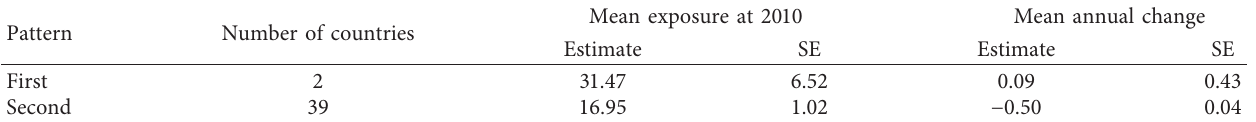
Table 2: The number of countries and mean annual change for each